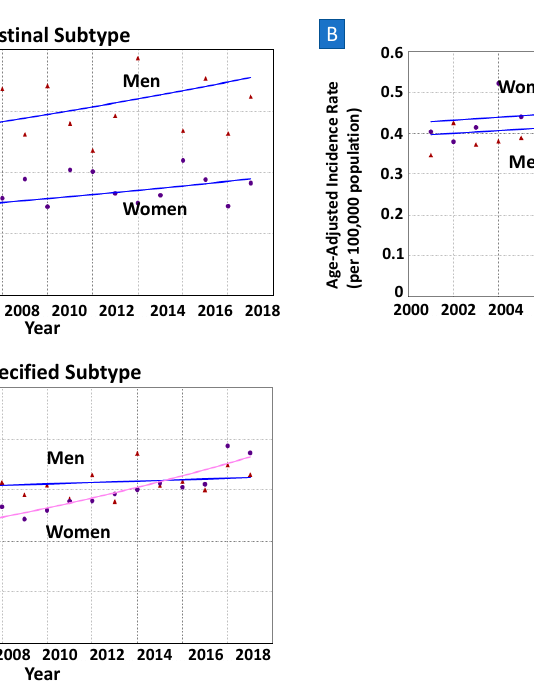
Figure 3. ( A – C ) Sex-specific incidence trends among younger adults by histopathology based on Lauren’s criteria. All data are from SEER database, among those of age < 55 years. Lines of both men and women are same colors if trends are parallel, meaning same APC and AAPC values during the interval years. ( A , B ) Based on Lauren’s criteria, both intestinal and diffuse subtype groups showed parallel incidence trends between men and women ( p -values 0.29 and 0.83, respectively). ( C ) Of the unspecified subtype, women had statistically significant increase in incidence compared to counterpart men in nonparallel trend (AAPC 3.62% vs. 0.43%; p -value < 0.01).